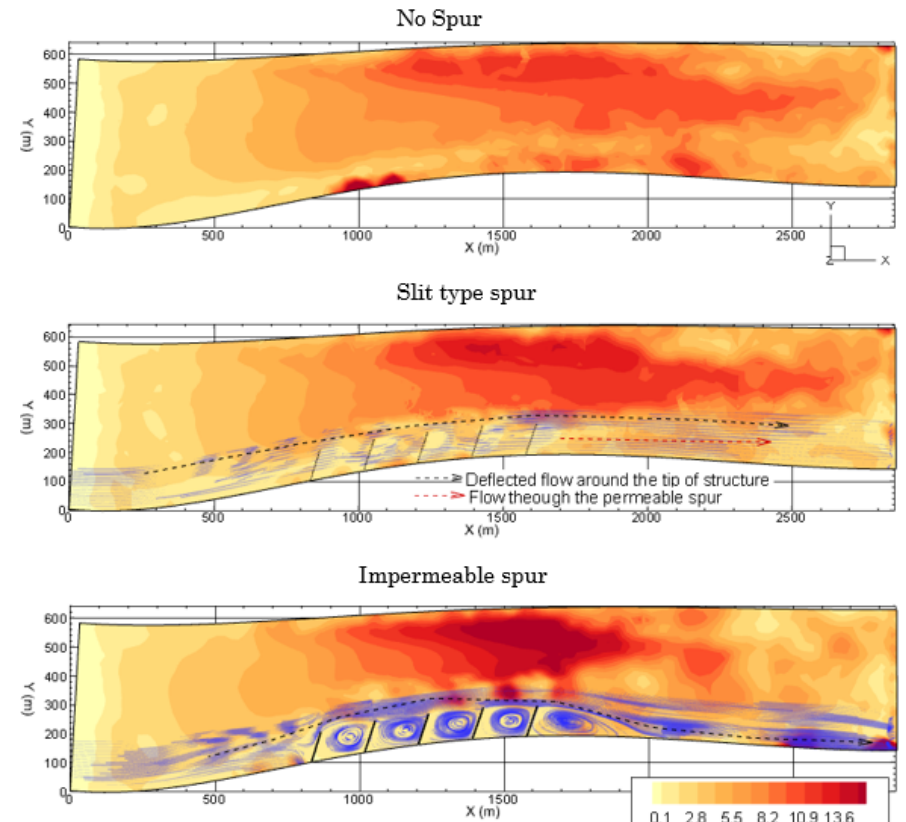
Figure 21. The distribution of the bed shear stress along the spur zone (the blue line shows the stream trace).